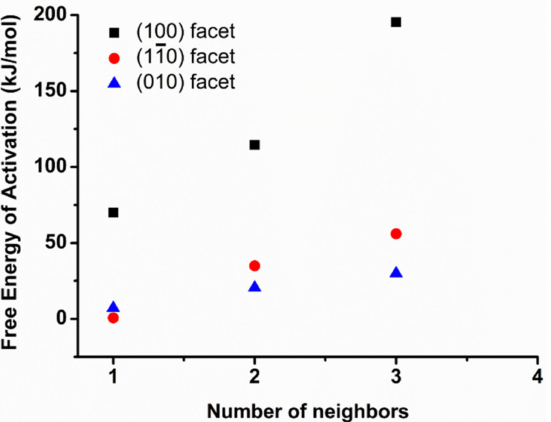
Figure 6. Correlation diagram of free energy of activation of central Ca (violet Ca in Figure 2) of (100), (110), and (010) crystalline facets of Portlandite as a function of number of Ca neighbors at 298 K.